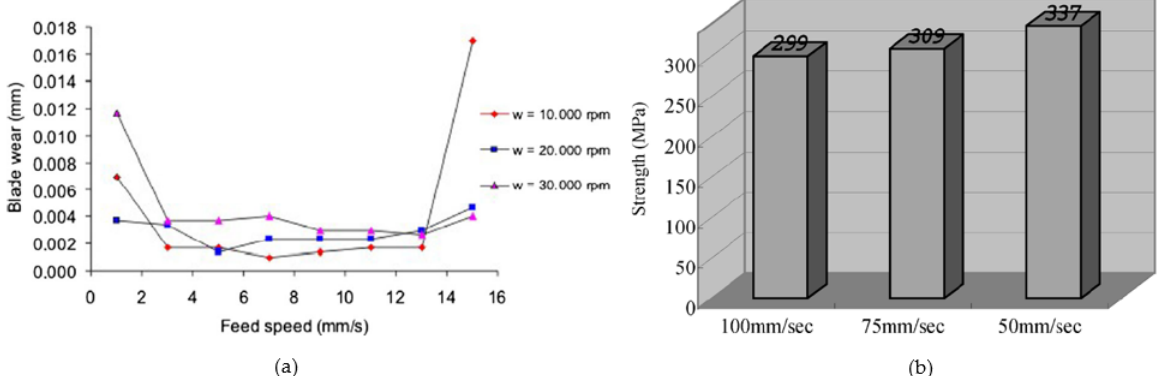
Figure 19. ( a ) Average wearing on the blades as a function of the feed speed for the rotations of 10,000, 20,000, and 30,000 rpm; ( b ) chip strength of a wafer diced at feeding rates of 100, 75, and 50 mm/s [45,76].